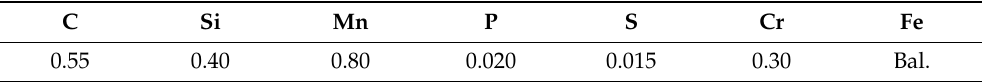
Table 1. Chemical compositions of ER8 wheel steel (mass fraction/%).